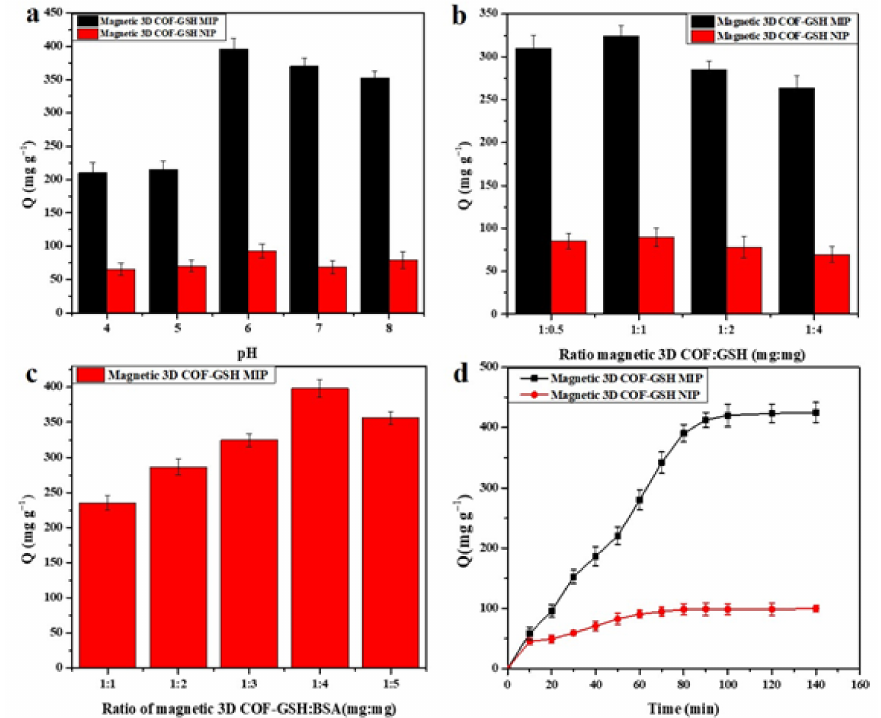
Figure 3. ( a ) Optimization of pH solution on adsorption, ( b ) optimization of the ratio between magnetic 3D COFs and GSH, ( c ) optimization of the ratio between magnetic 3D COF–GSH and BSA, and ( d ) adsorption kinetics of magnetic 3D COF–GSH MIPs and